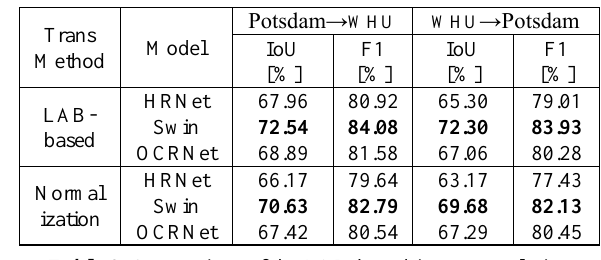
Table 2 . Comparison of the LAB-based image translation